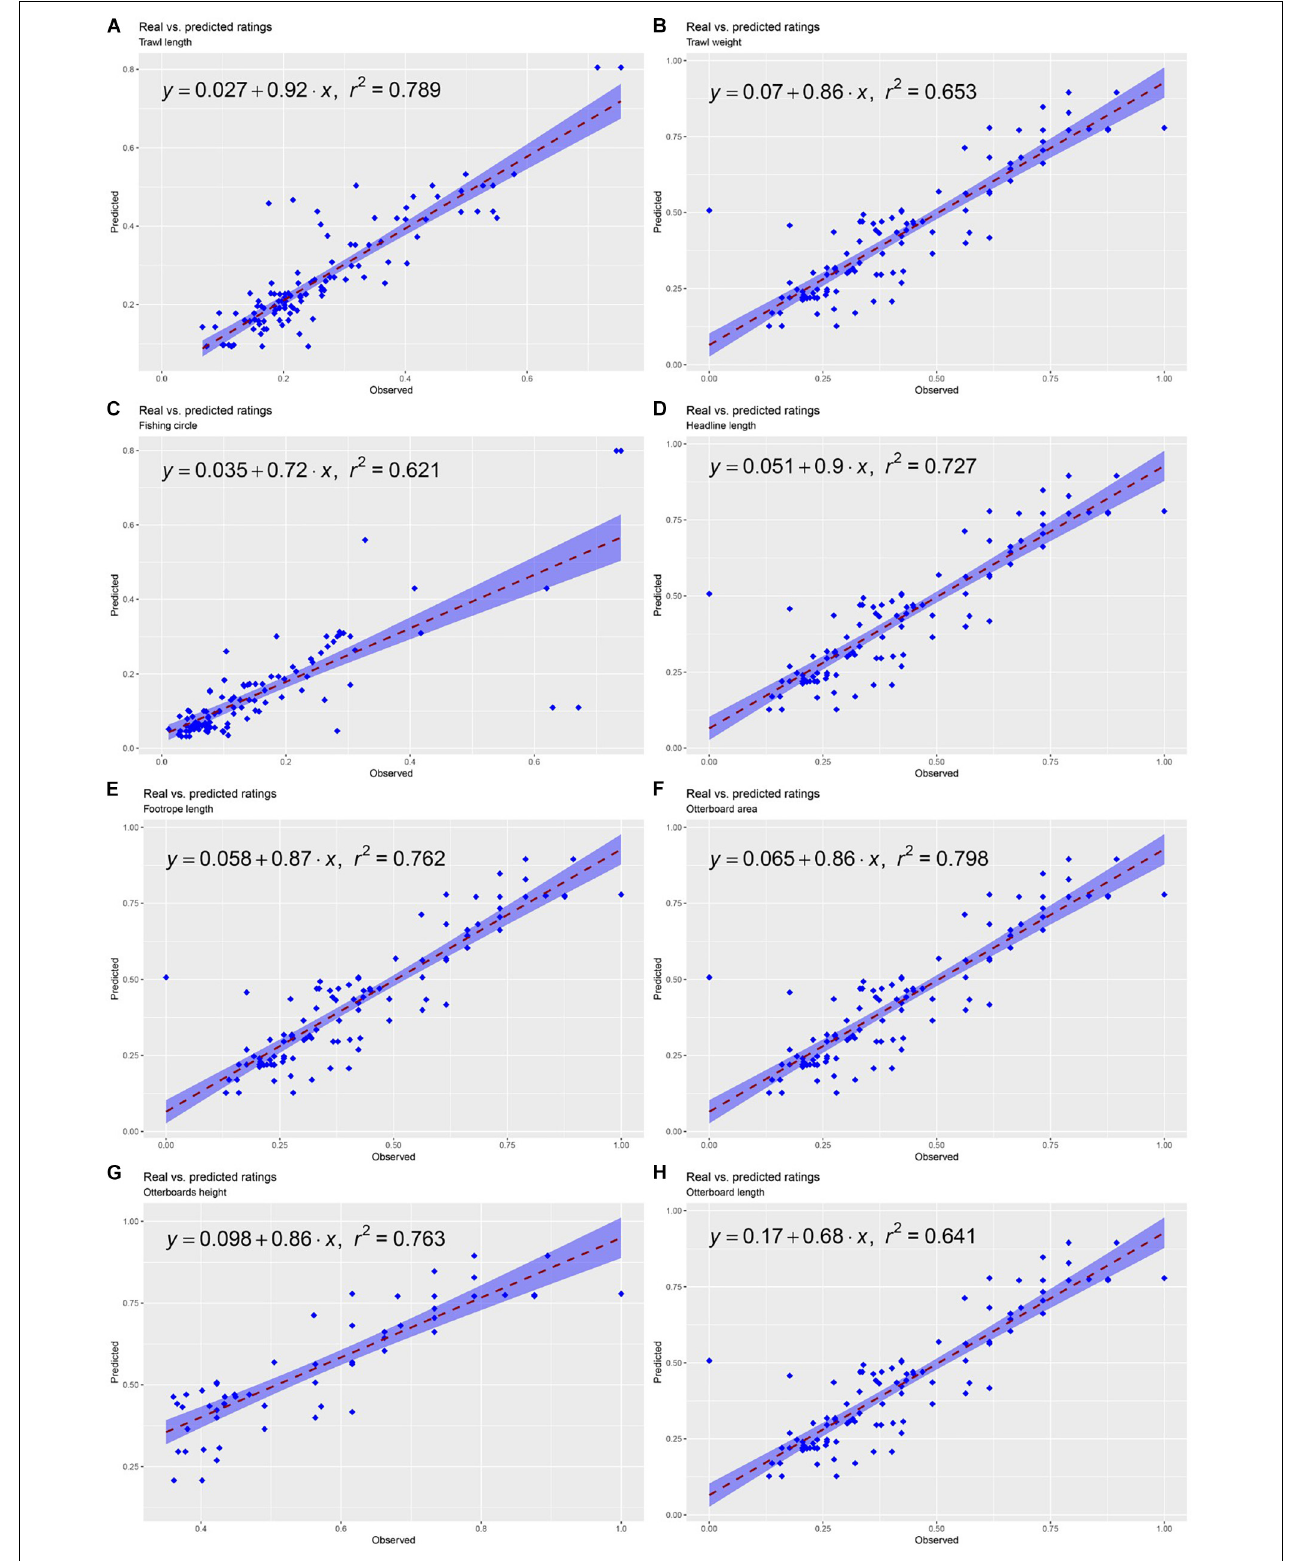
FIGURE 7 | Summary of the evaluation of the SOM predictive performance. (A) Trawl length, (B) Trawl weight (C) Fishing circle, (D) Headline length, (E) Footrope length, (F) Otterboard area, (G) Otterboard height, (H) Otterboard length.